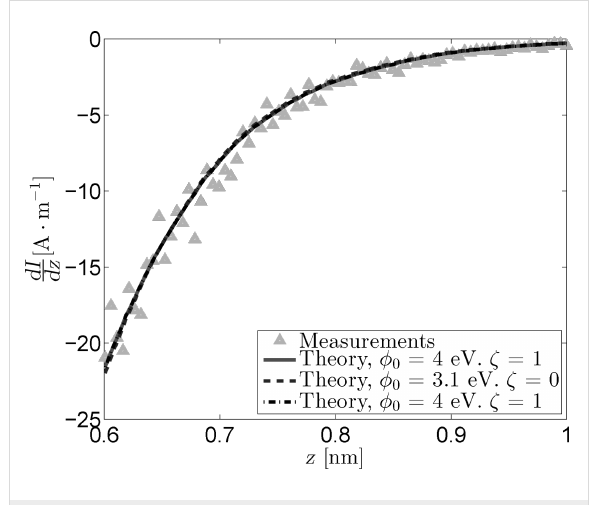
Figure 7: Measured and reconstructed dI / dz data obtained from I ( z ) measurements for γ = 0.5. The masking effect between and ζ remains, but changes in these parameters do not significantly impact the effective barrier, leading to all reconstructed traces overlapping. The free parameter fit (solid line) leads to the maximum value for ξ (i.e., ξ = 1), causing the fitted parameters to be identical to those obtained from the fit with ξ fixed at its maximum value (dashdotted line).